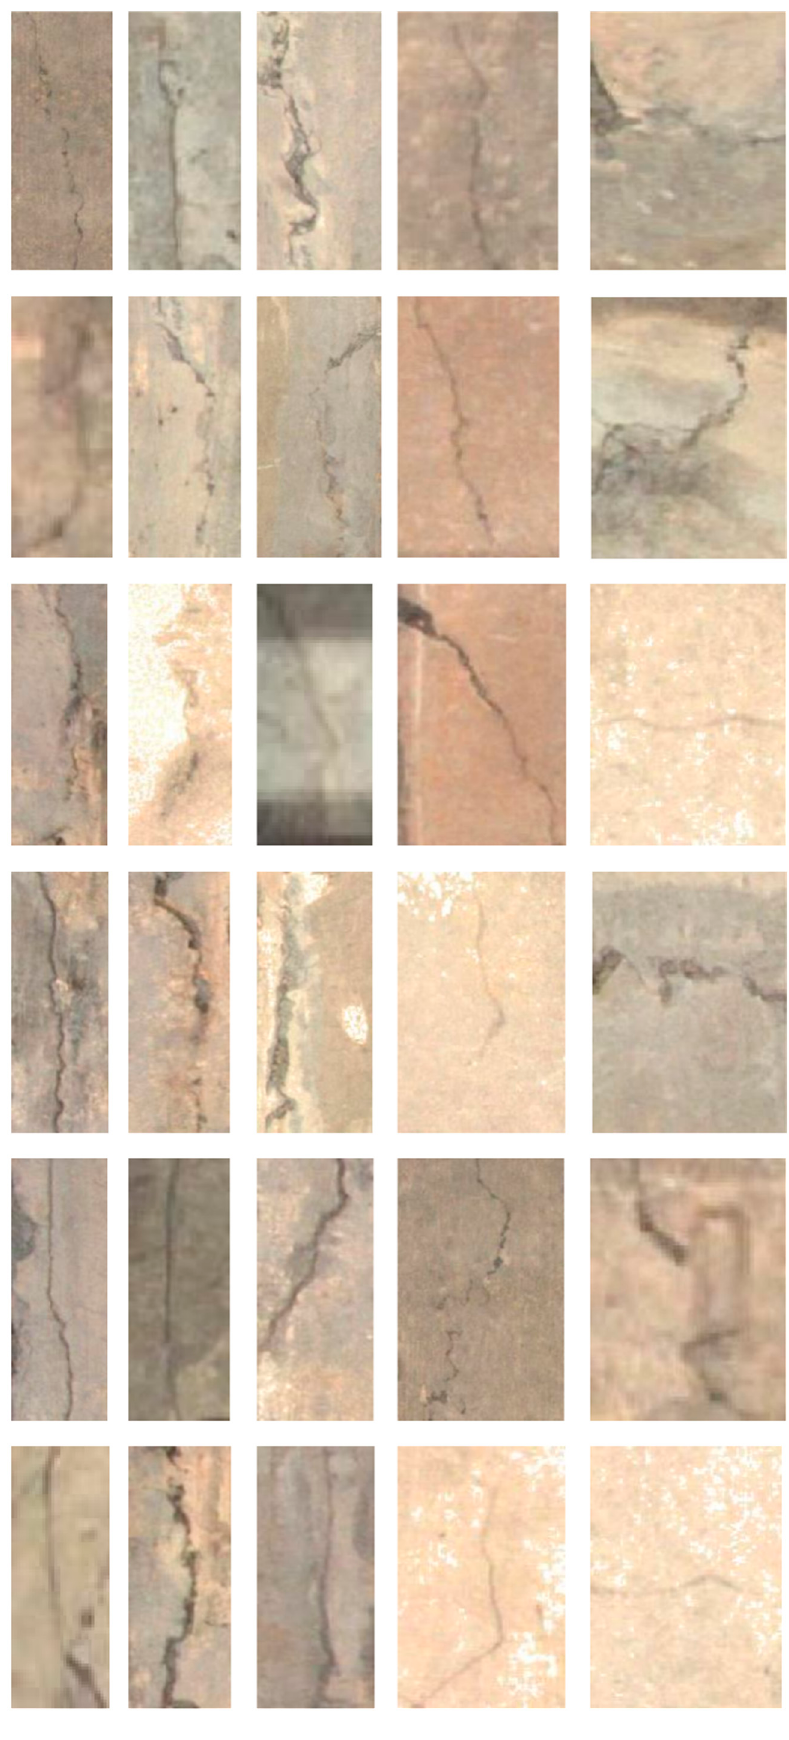
Figure 5. The crack images for the Mask R-CNN algorithm.